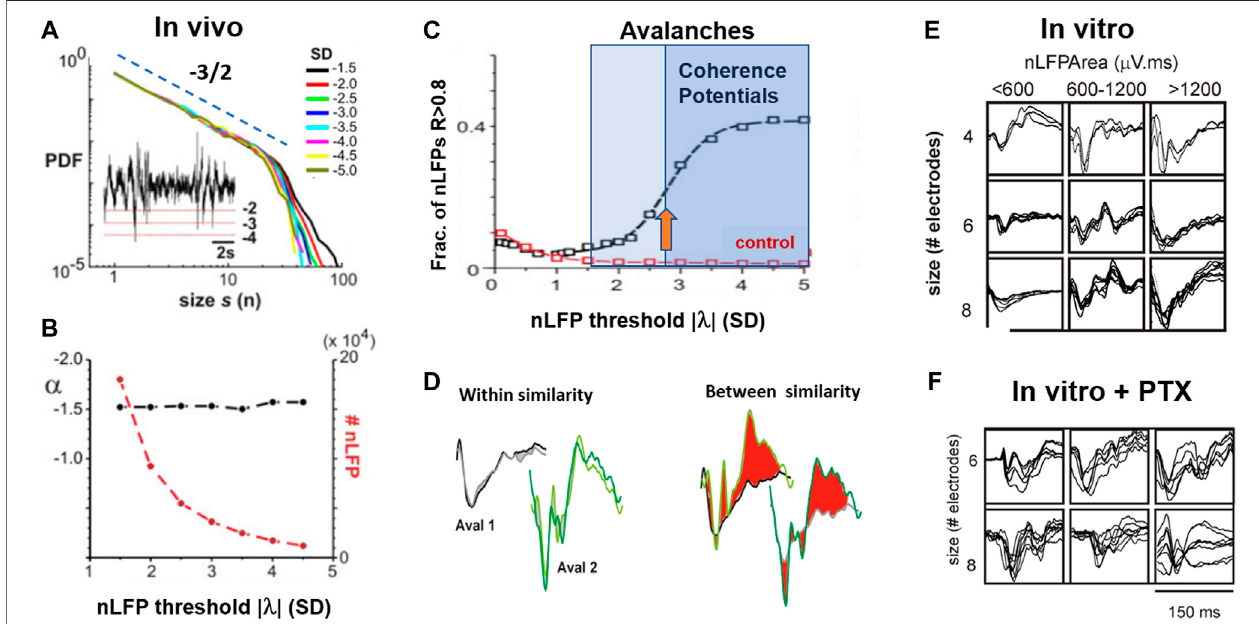
FIGURE6| Thefourthdynamicalmotifofself-organization:Thecoherencepotential. (A) LFPavalanchesfromongoingactivityinnonhumanprimateshowarobust power law in sizes for a range in threshold λ at which nLFPs are detected. Inset : example LFP trace and nLFP detection for three different values of λ . SD : standard deviation. Broken line : slope of − 3/2. (B) The number of nLFPs > λ drops several orders of magnitude with an increase in λ , while the power law in sizes remains robust with slope α close to − 3/2. (C) The similarity in nLFP waveforms within avalanches rapidly increases for λ > ∼ 2.7 SD ( orange arrow ). This threshold-dependent sigmoidal increase in within-nLFP similarity identi fi es a relatively small number ( ∼ 20%) of nLFPs that constitute coherence potentials (cf. B ). Control : expected change in similarityafter random temporalshiftsin theLFP. (D) Complex nLFPwaveforms withinacoherence potential arehighly similar.Example comparison fortwosubsequent coherencepotentialsattwosites.Withinsimilarity( gray/black ; light/darkgreen )ishighforeachcoherencepotential( CP ),whereasbetweensimilarityisverylowwithlarge waveform deviations highlighted in red for visual contrast. (E) Coherence potentials spontaneously form in vitro in organotypic cultures. Overplot matrix of waveform examples for coherence potentials of size four to eight for nLFP areas in three size categories. (F) Under disinhibited conditions ( PTX ), coherence potentials are absent (reproduced with permission from [11]).